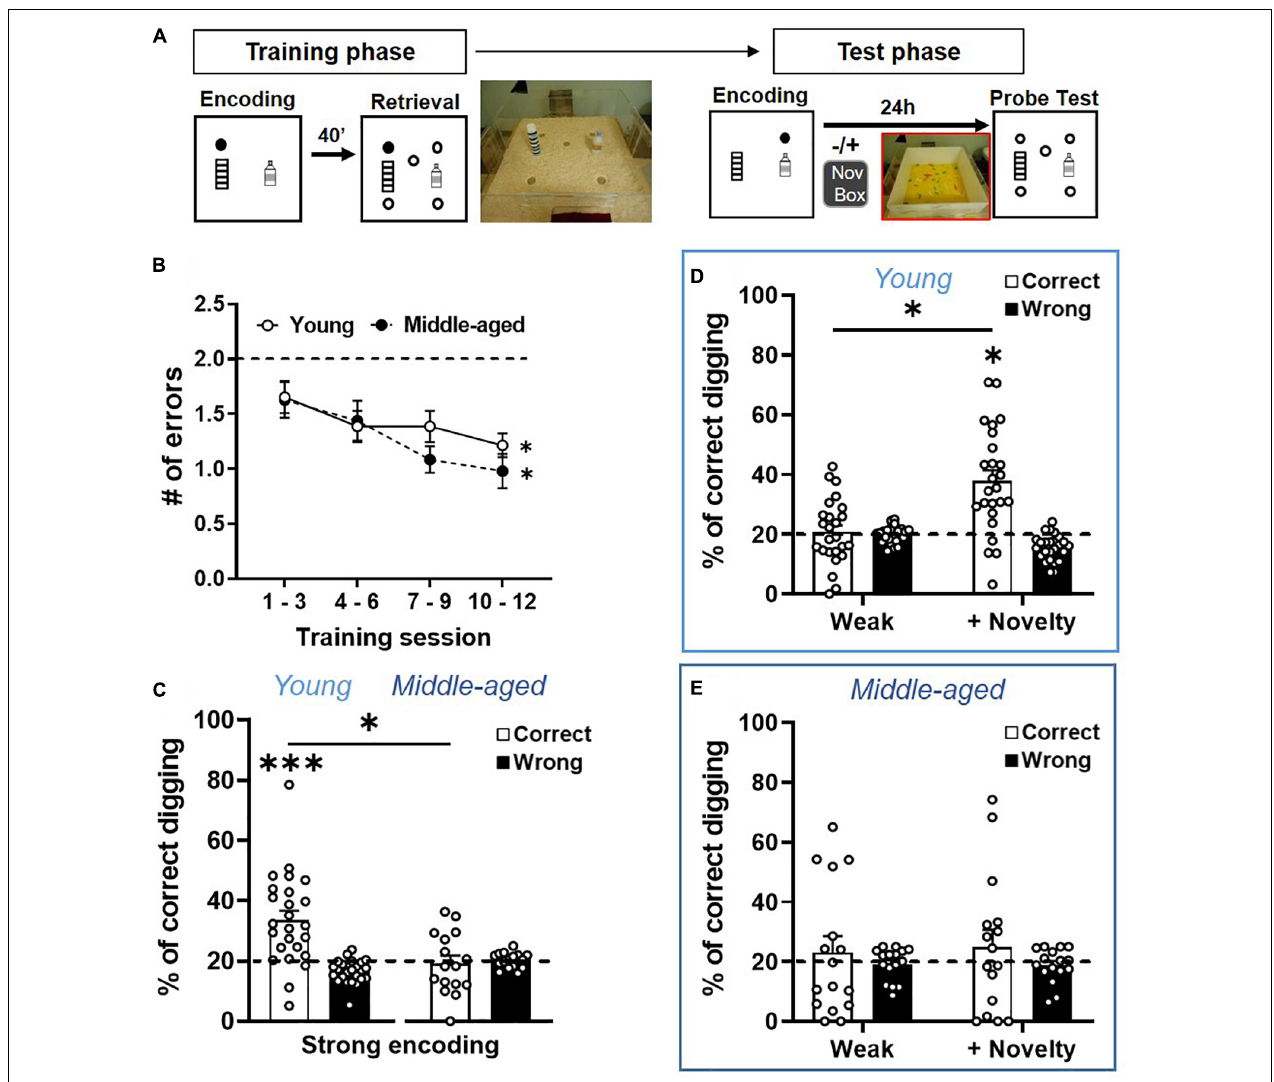
FIGURE 3 | Long-term memory persistence and modulated memory persistence are impaired in aging . (A) Behavioral procedures of ADMP training and testing. Rats were trained to find hidden rewards in a sand well (the filled circle) inside the arena. After a delay, the rats had access to the arena with five sand wells, but only the matching location, which was rewarded in the encoding phase, contained more rewards. There were 12 encoding-retrieval training sessions. Memory retention was tested after weak (1 pellet) or strong (3 pellets) encoding, at 24-h delay, in a non-rewarded probe trial (open circles). Exploration of a novel environment (box) could be introduced 30 min after encoding. (B) The number of errors decreased across the 4 blocks of training sessions in the young and middle-aged rats. The dashed line indicates the chance level. (C) Long-term memory retention after strong encoding showed that the percentage of correct digging was significantly above chance (the dashed line) in the young rats, but not in the middle-aged rats. (D) Long-term memory retention after weak encoding showed performance near chance (the dashed line), while novelty significantly improved the memory. (E) Long-term memory retention after weak encoding showed performance near chance, and novelty did not improve the memory. All data are presented as mean ± SEM. ∗ p < 0.05 and ∗∗∗ p <